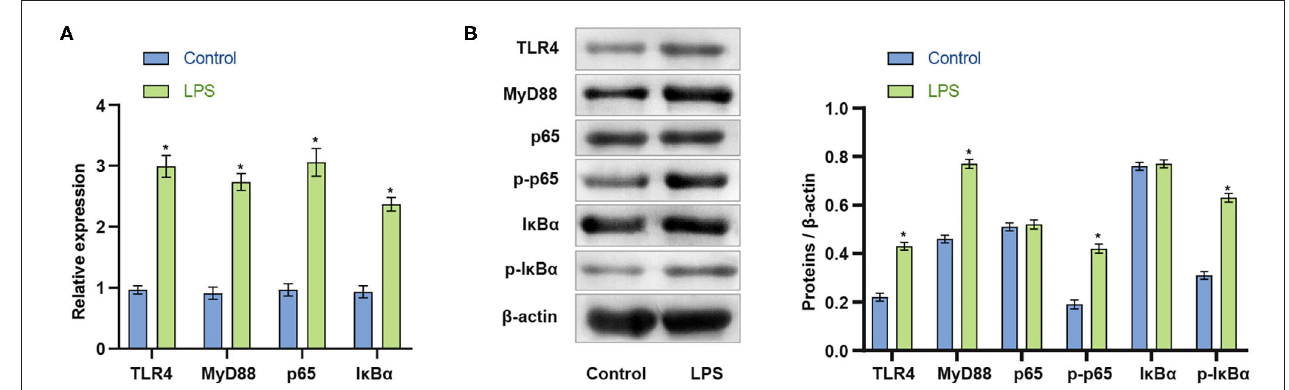
FIGURE 2 | LPS activates the TLR4/MyD88 signaling pathway in microglia. (A) The expression of TLR4, MyD88, p65, and I κ B α increased after LPS stimulation of BV2 cells. (B) Western blot measurement of the expression of MyD88, TLR4, p65, p-p65, I κ B α , and p-I κ B α protein in BV2 cells. * P < 0.05 compared with the Control group. The unpaired t -test was used to analyze comparisons between two